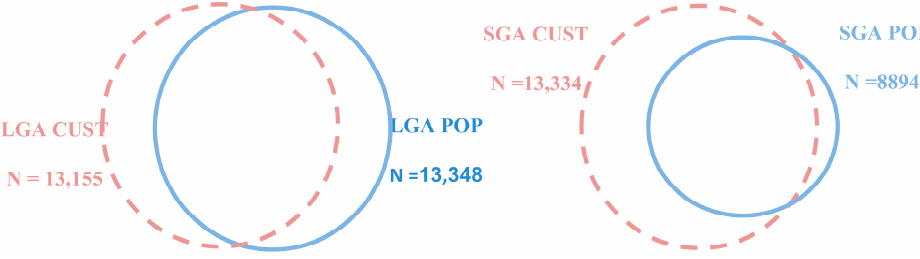
Figure 3. The relationship between the SGA and LGA study group groups (Venn diagram). LGA, large for gestational age; CUST, customized model adjusted for gestational age, gender, and parity; SGA, adverse outcomes in small; POP, population-based model adjusted for gestational age and gender